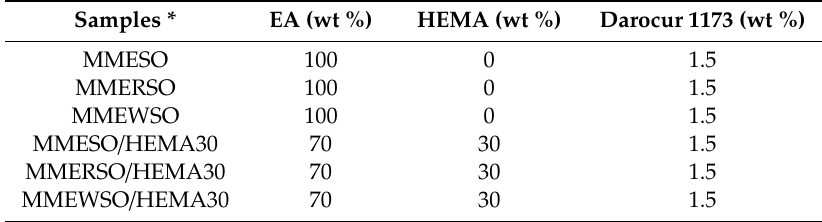
Table 1. Composition of UV-cured epoxy acrylate (EA)-like samples. HEMA: hydroxyethyl methacrylate. Samples